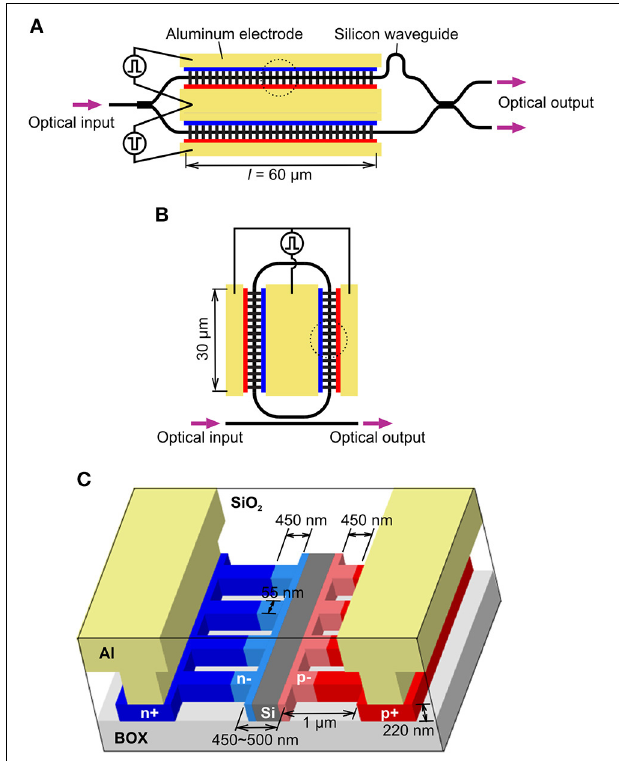
FIGURE 5 | Fabricated (A) MZ modulator and (B) microring modulator. (C) Detailed structure of phase shifter indicated as close ups of dotted circles in (A) and (B)